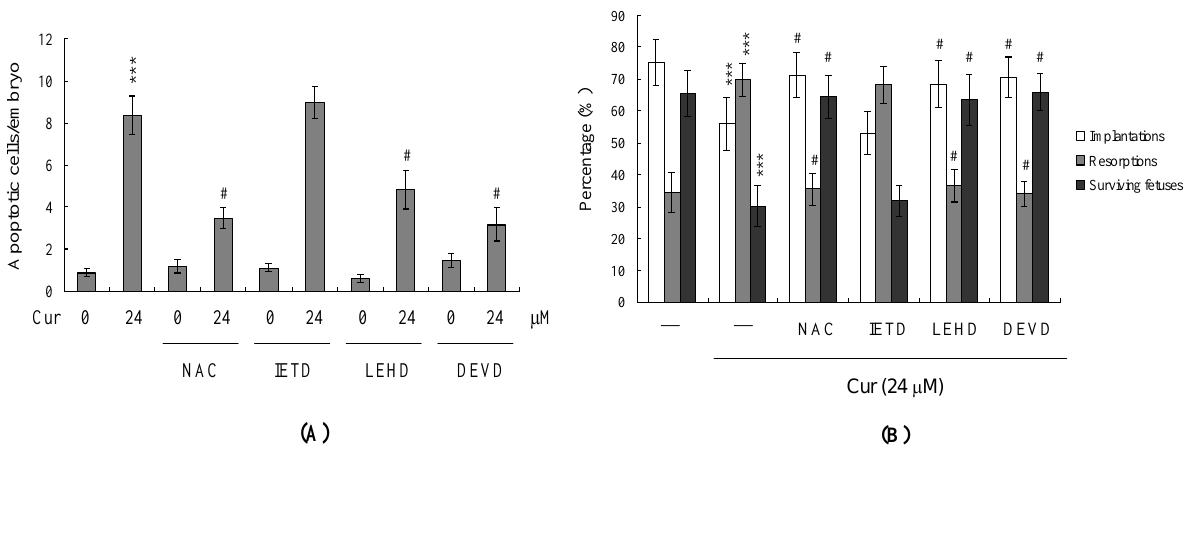
Figure 6. Effects of ROS scavengers and caspase inhibitors on in vivo implantation, resorption, fetal survival and fetal weight in curcumin-treated embryos. Mouse blastocysts were pretreated with 400 μM N-acetyl cysteine (NAC), 300 μM Z-IETD-FMK (IETD), 300 μM Z-LEHD-FMK (LEHD) or 300 μM Z-DEVD-FMK (DEVD) for 1 h or left untreated. Blastocysts were further incubated with curcumin (Cur, 24 μM) for another 24 h. ( B ) Implantations, resorptions and surviving fetuses were analyzed by embryo transfer, as described in Materials and Methods and Figure 4. ( C ) The weight distribution of surviving fetuses on day 18 post-coitus. Surviving fetuses were obtained by embryo transfer of control and curcumin-pretreated blastocysts (320 total blastocysts across 40 recipients). *** P < 0.001 versus the curcumin-free group and #P < 0.001 versus 24 μM curcumin-treated